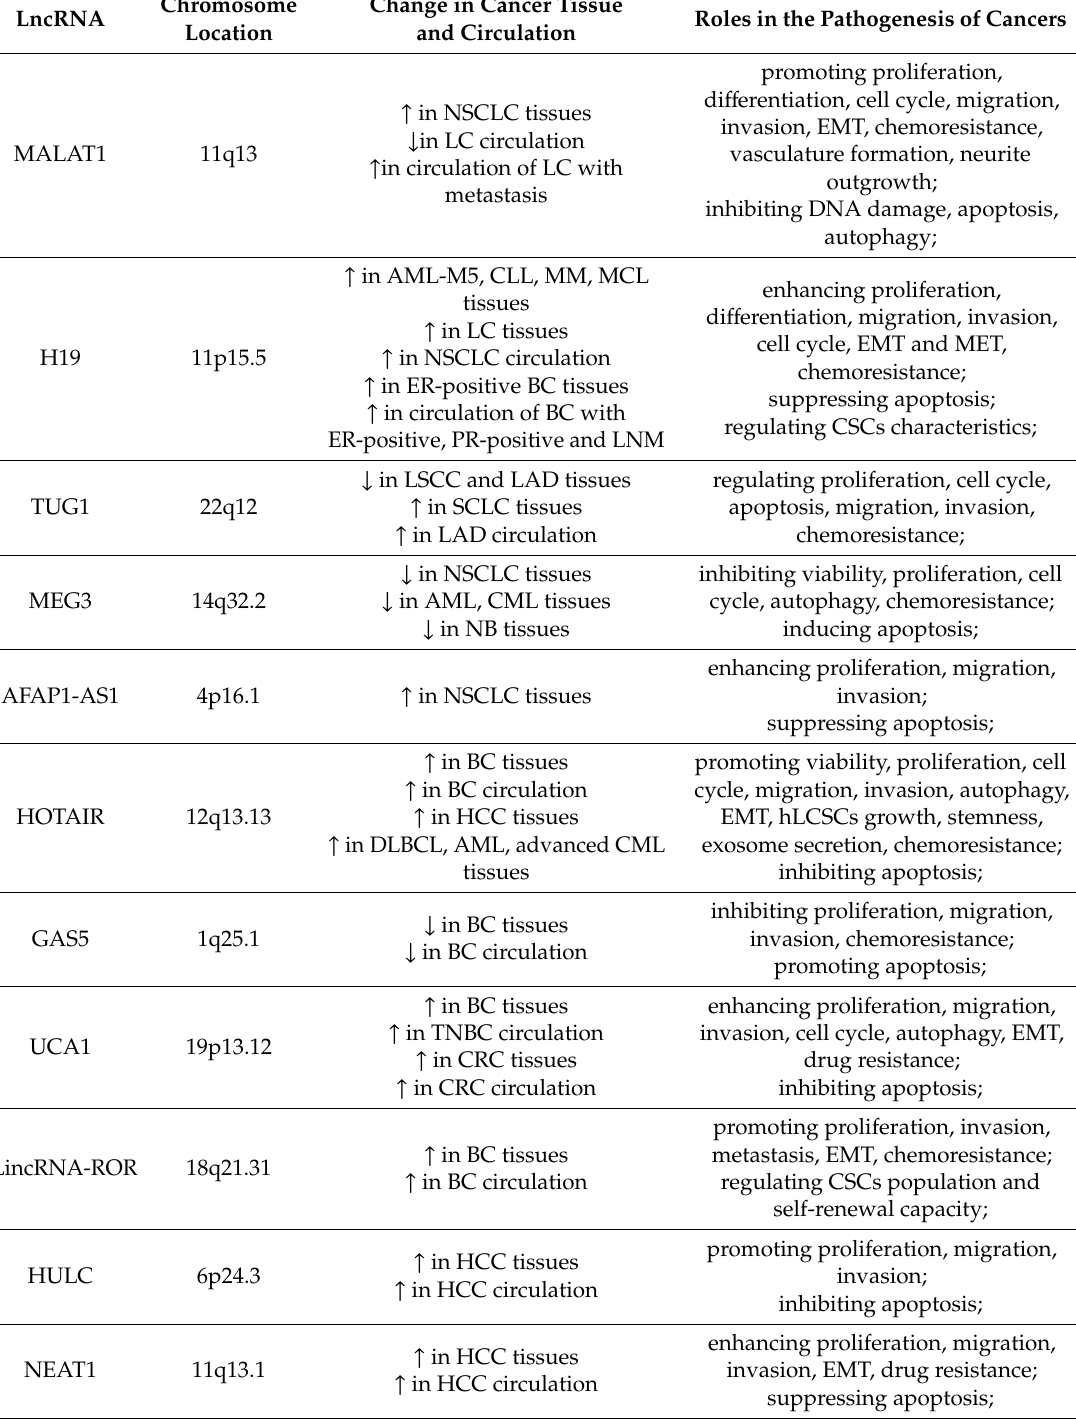
Table 2. Summarization of the roles and mechanisms of discussed lncRNAs in the pathogenesis of